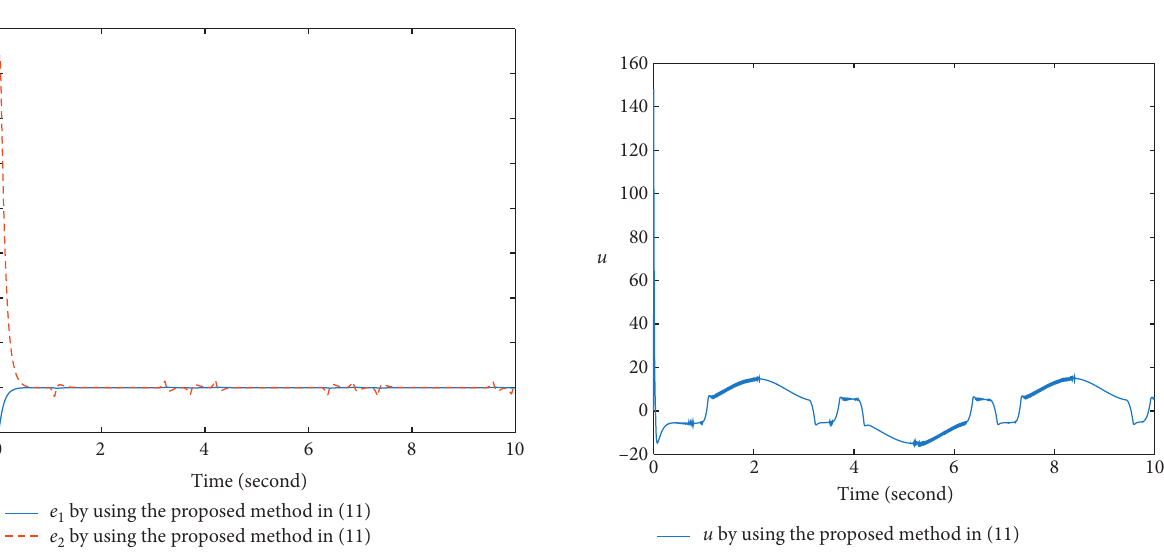
Figure 6: Trajectories of f ( t,x ) and λ − 1 􏽢 η T ϖ the proposed method in (11).